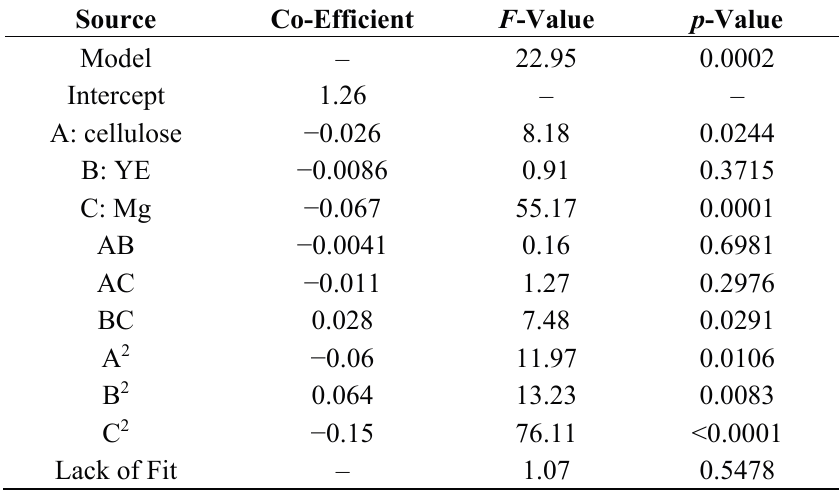
Table 4. Reduced quadratic model obtained for molar yields of H 2 . Model co-efficients are presented in terms of coded